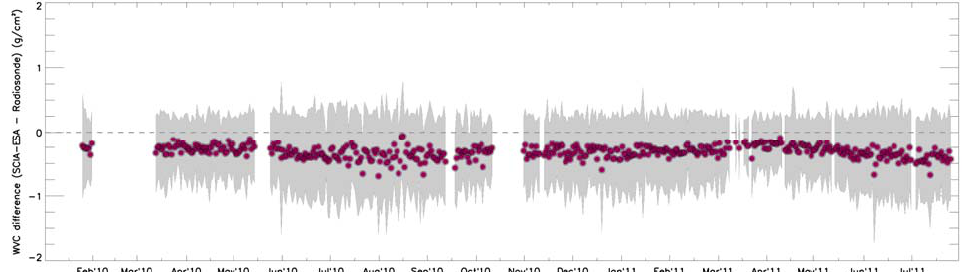
Fig. 2. The global daily difference between SCIAMACHY-ESA WVC amounts and radiosonde WVC as a function of time (1 February 2010 to 10 August 2011). Each purple circle indicates the daily mean WVC difference (SCIAMACHY-ESA minus radiosonde) per day, where the number of measurements per radiosonde station has been used as a weight. Vertical grey lines indicate the standard deviation.